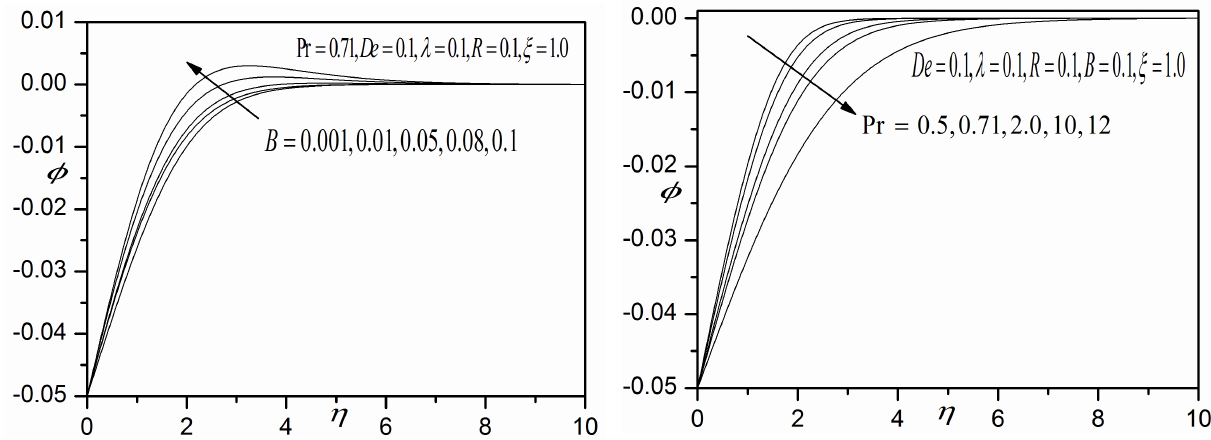
Fig. 16: Influence of Pr on the angular